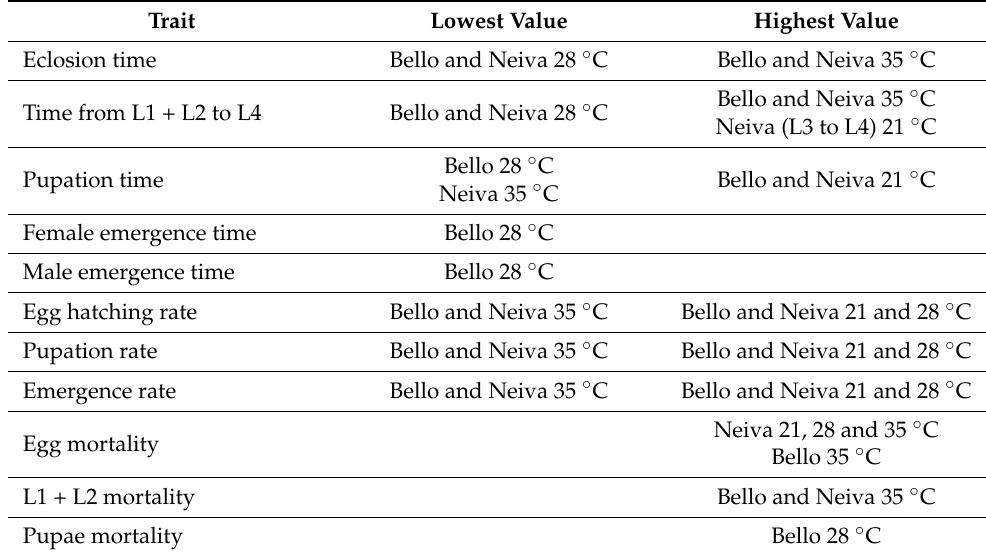
Table 2. Summary of the results from two populations reared at 21 ± 1 ◦ C, 28 ± 1 ◦ C and 35 ± 1 ◦ C temperatures, 80 ± 5% relative humidity, and 12 h light: 12 h dark photoperiod. For each trait, only populations with extreme values that are significantly different are shown. Trait Lowest Value Highest Value Eclosion time Bello and Neiva 28 ◦ C Bello and Neiva 35 ◦ C Bello and Neiva 35 ◦ C Time from L1 + L2 to L4 Bello and Neiva 28 ◦ C Neiva (L3 to L4) 21 ◦ C Bello 28 ◦ C Pupation time Bello and Neiva 21 ◦ C Neiva 35 ◦ C Female emergence time Bello 28 ◦ C Male emergence time Bello 28 ◦ C Egg hatching rate Bello and Neiva 35 ◦ C Bello and Neiva 21 and 28 ◦ C Pupation rate Bello and Neiva 35 ◦ C Bello and Neiva 21 and 28 ◦ C Emergence rate Bello and Neiva 35 ◦ C Bello and Neiva 21 and 28 ◦ C Neiva 21, 28 and 35 ◦ C Egg mortality Bello 35 ◦ C L1 + L2 mortality Bello and Neiva 35 ◦ C Pupae mortality Bello 28 ◦